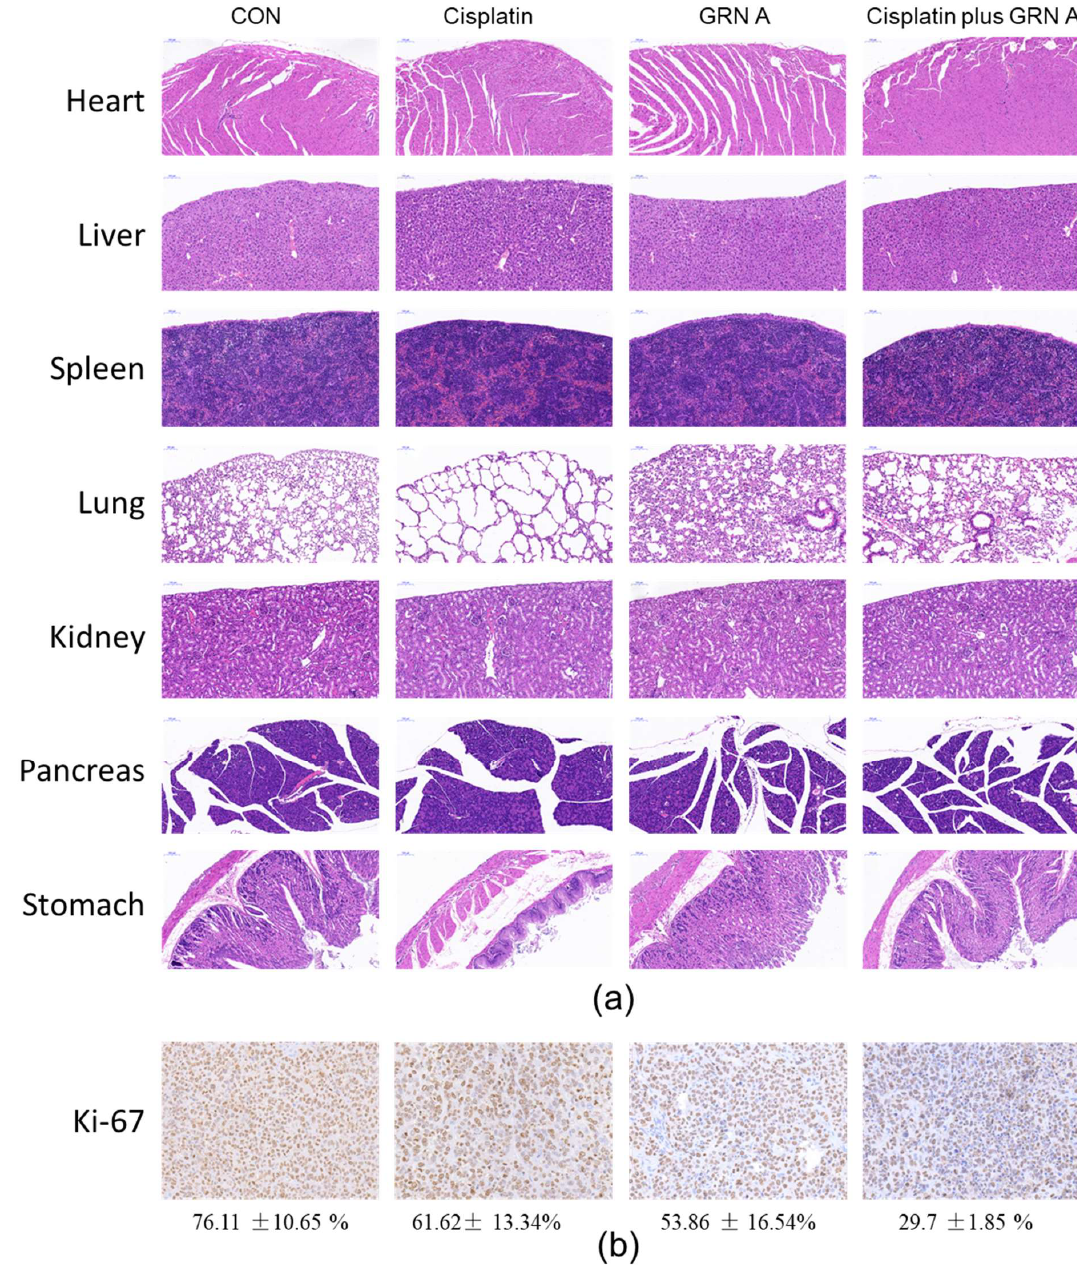
Figure 6. Histological analysis of seven principal organs excised from HepG2 tumor-bearing mice ( a ), and immunohistochemically (IHC) analyses of tumors ( b ) belonging to untreated group, cisplatin-treated (5 mg/kg), GRN A-treated (50 mg/kg) and combination of cisplatin with GRN A. Scale bar, 100 μm.